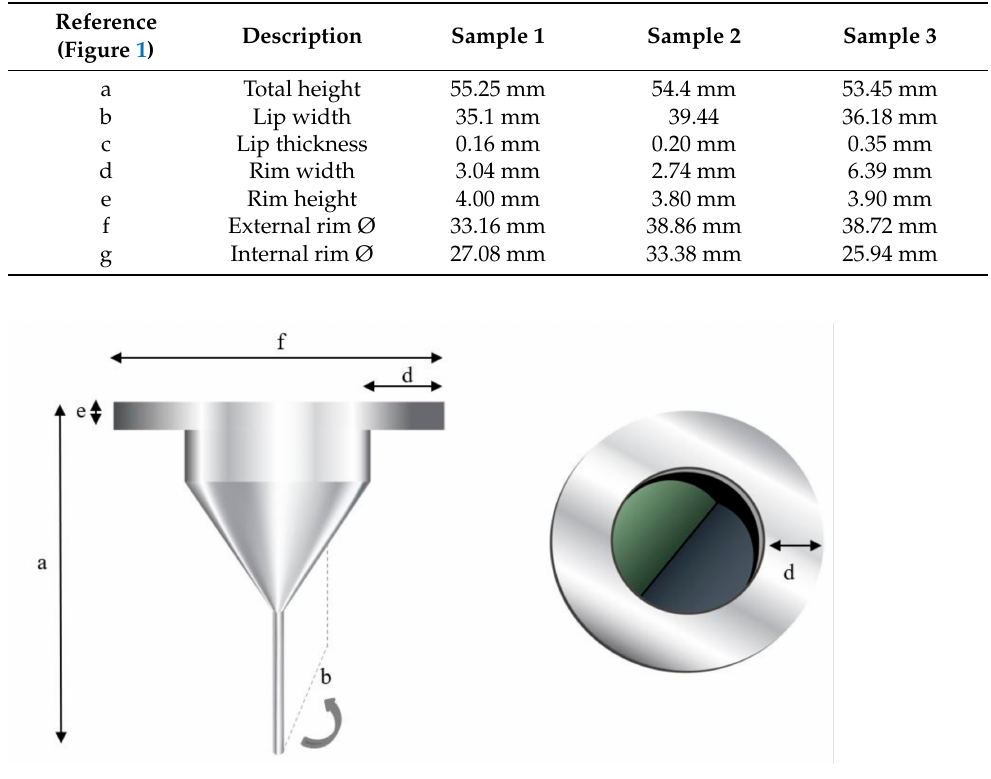
Figure 1. Measurement key for a typical waterless trap seal (dimensions are given in Table